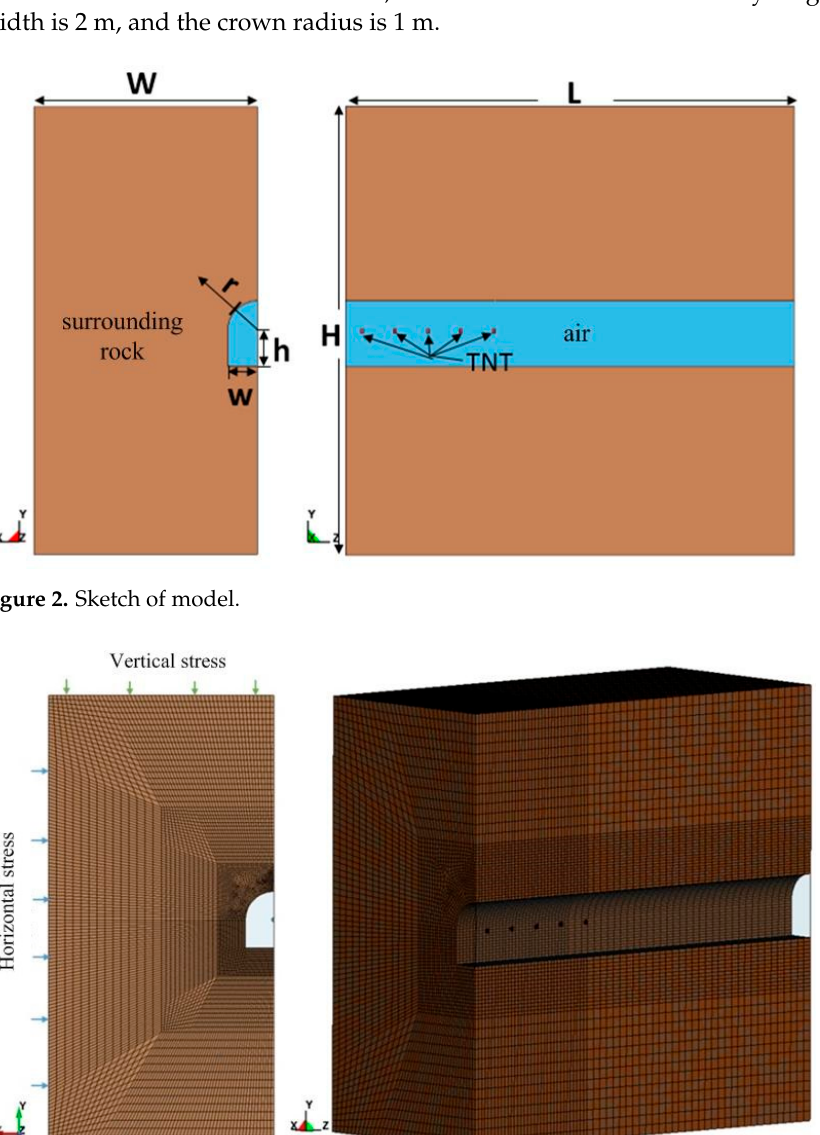
Figure 4. Positions of measuring points. ( a ) Wall measuring point of roadway axis and ( b ) Wall measuring point of roadway section